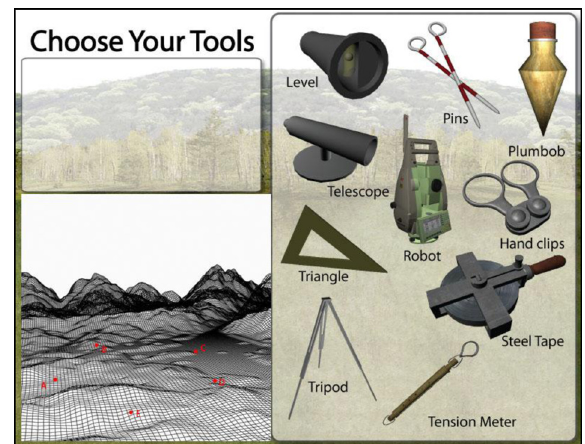
Figure 4. A screenshot of the 3D program showing the 3D virtual instruments and the polygon mesh of one of the terrains.